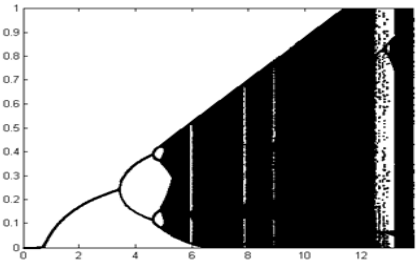
∈ [0, 13.8], and X 0 = 0.02 [39].